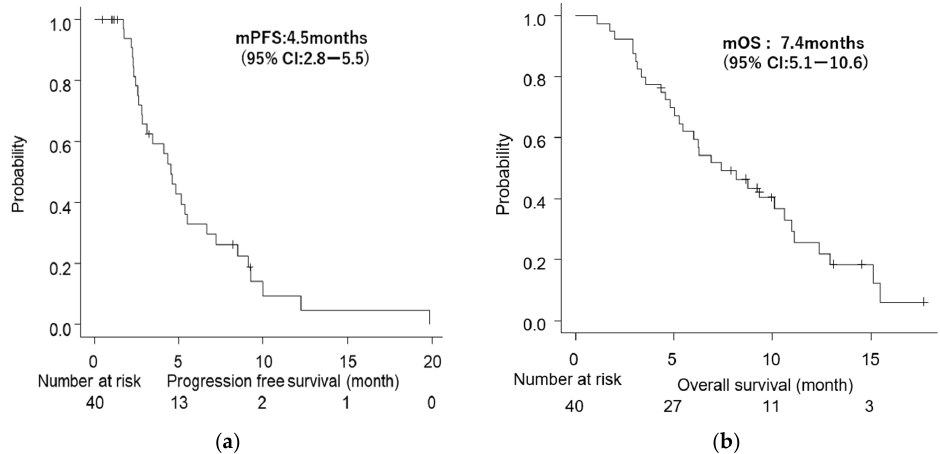
Figure 1. Kaplan–Meier survival analyses. ( a ) Progression-free survival (PFS) of all patients. ( b ) Overall survival (OS) of all patients; CI, confidence interval, and p -value were calculated using the log-rank test.